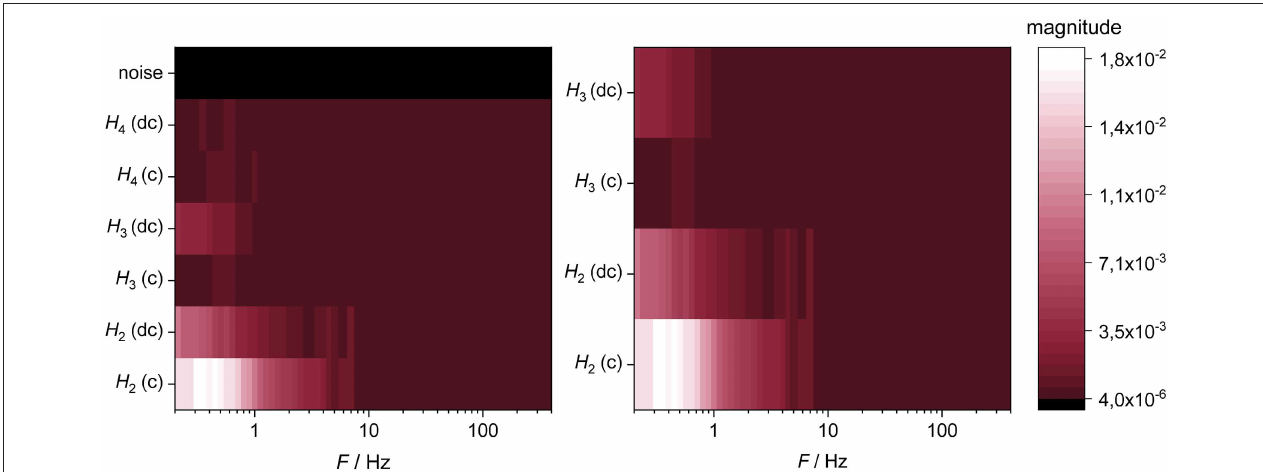
FIGURE 6 | Visualization of the frequency dependent occurrence of the higher harmonics (H2–H4) in charge (c) and discharge direction (dc) and the corresponding random noise of the measurement setup at a cell voltage of 3.3V. The figure to the right shows a magnification of the left one. The experiment was performed at a temperature of 20 ◦